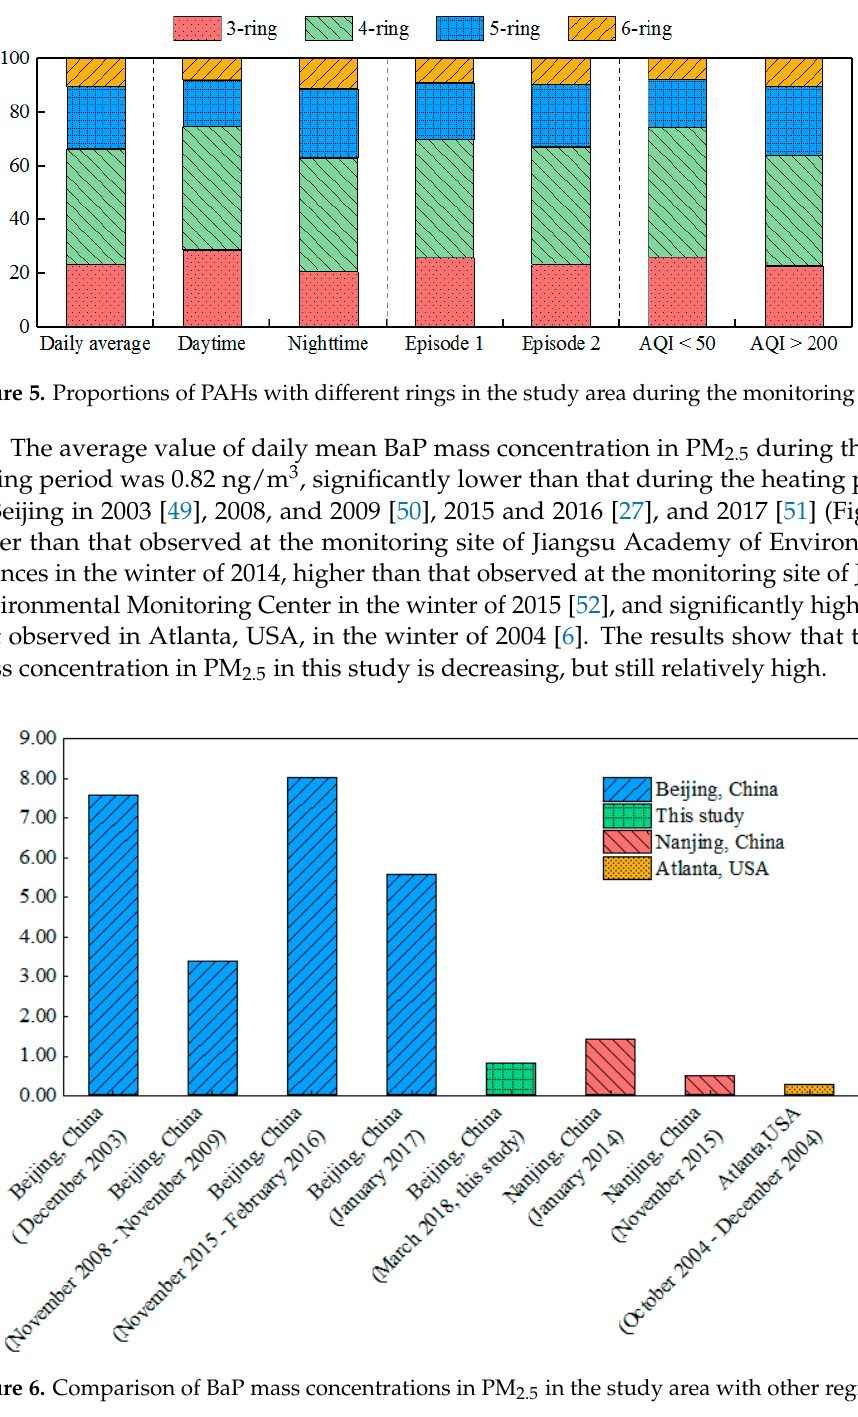
Figure 7. Daily and diurnal variation of mass concentrations of 15 PAHs in the study area during the monitoring period. Nineteen days of complete monitoring were conducted in the study area. The mass concentrations of 15 PAHs were higher in the nighttime than those in the daytime for 15 days (Figure 7). On 1–4, 7–9, 11–13, 16–20 March, the relative humidity was higher in the